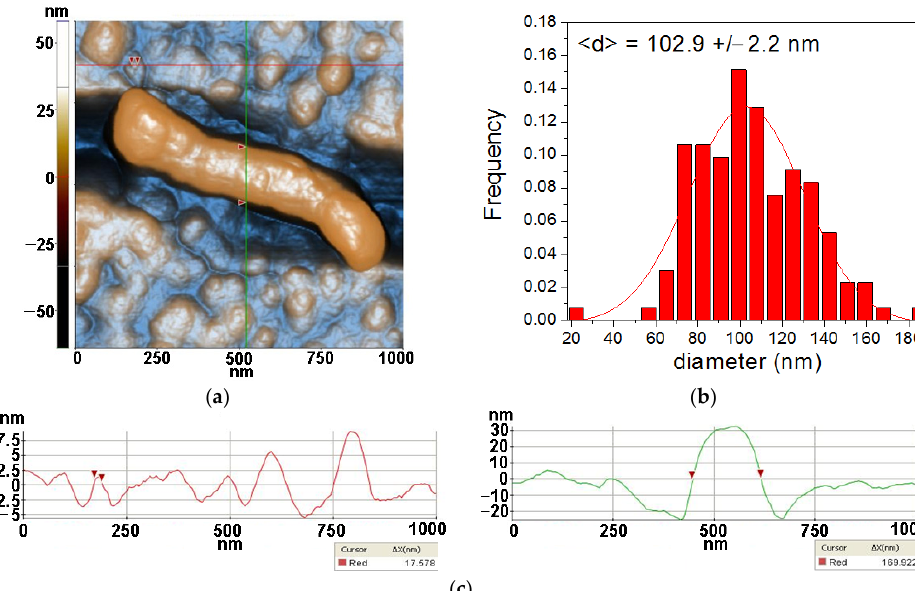
Figure 4. Two-dimensional AFM image scanned at the scale of (1 μ m × 1 μ m) for lysozyme deposited on bare Si substrate ( a ), particles’ diameters histogram for lysozyme deposited on Si fitted with a Gaussian distribution function ( b ) and two characteristic surface-profiles (line scans), horizontal and vertical ( c ).